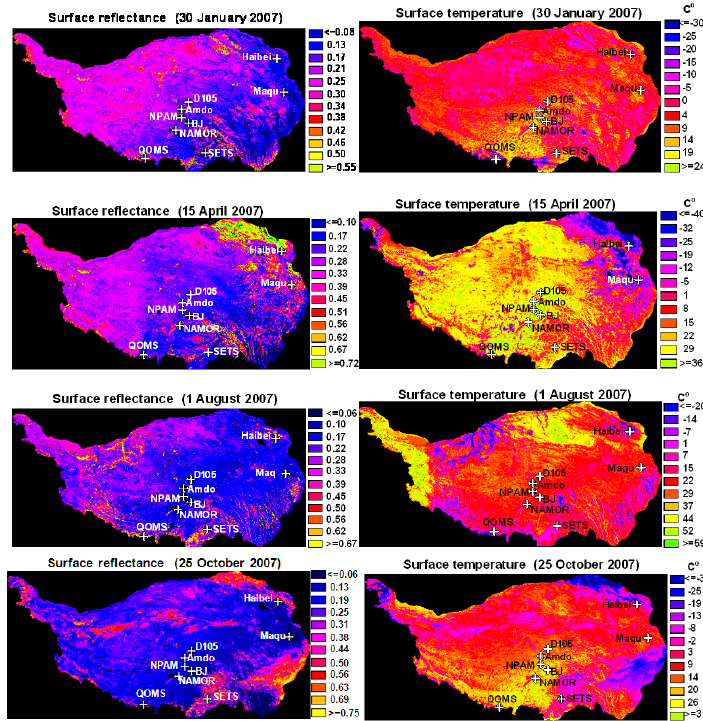
Fig.3. The distribution maps of surface reflectance and surface temperature over the Tibetan Plateau area.